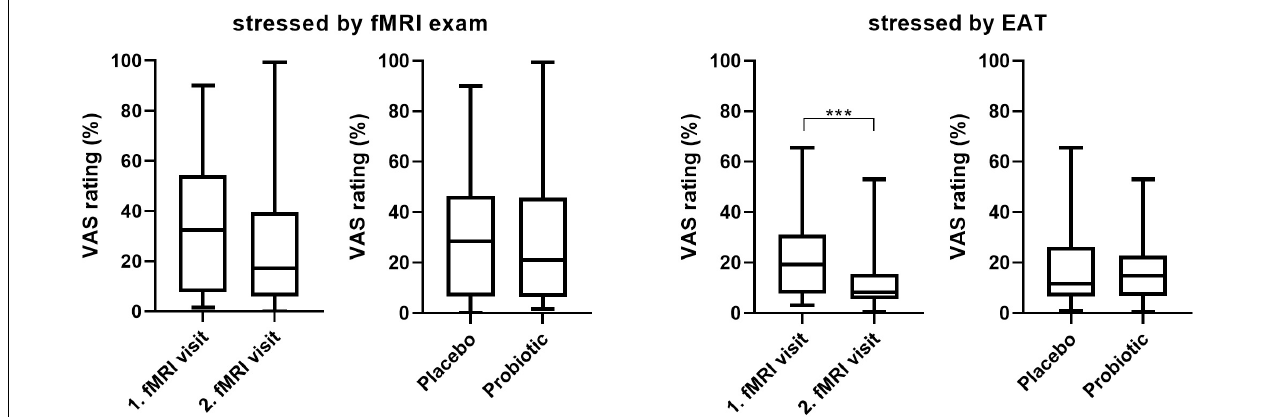
FIGURE 5 | Subjective stress ratings (VAS 0-100) of the fMRI examinations itself and the EAT paradigm by visit and intervention. Wilcoxon matched-pairs signed rank test; n = 22; *** p < 0.001; line presents median, box presents 25th and 75th percentile, whiskers present minimum to maximum. EAT, emotional attention task; fMRI, functional magnetic resonance imaging; VAS, visual analogous